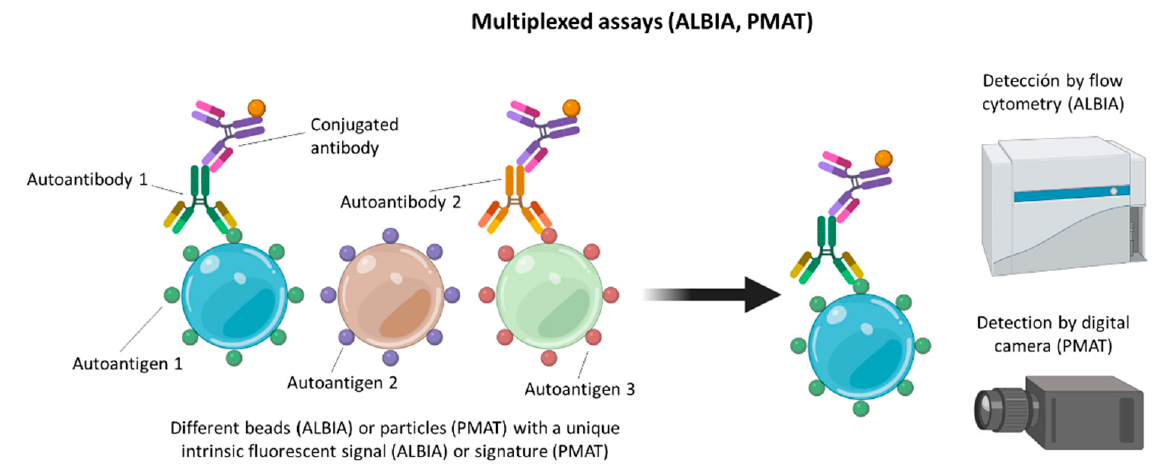
Figure 4. Multiplexed assays (ALBIA and PMAT) for autoantibody detection.